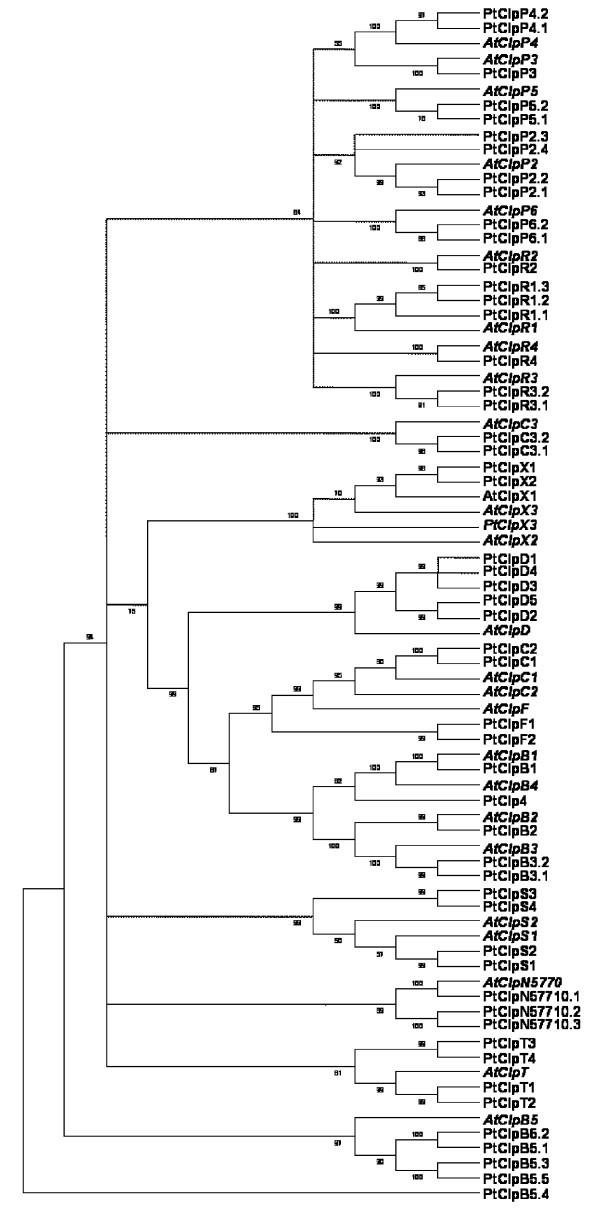
Maximum Parsimony Tree of the Clp protease family (S14 family in MEROPS). The names and the accession numbers for the different proteins are given in Table 4.